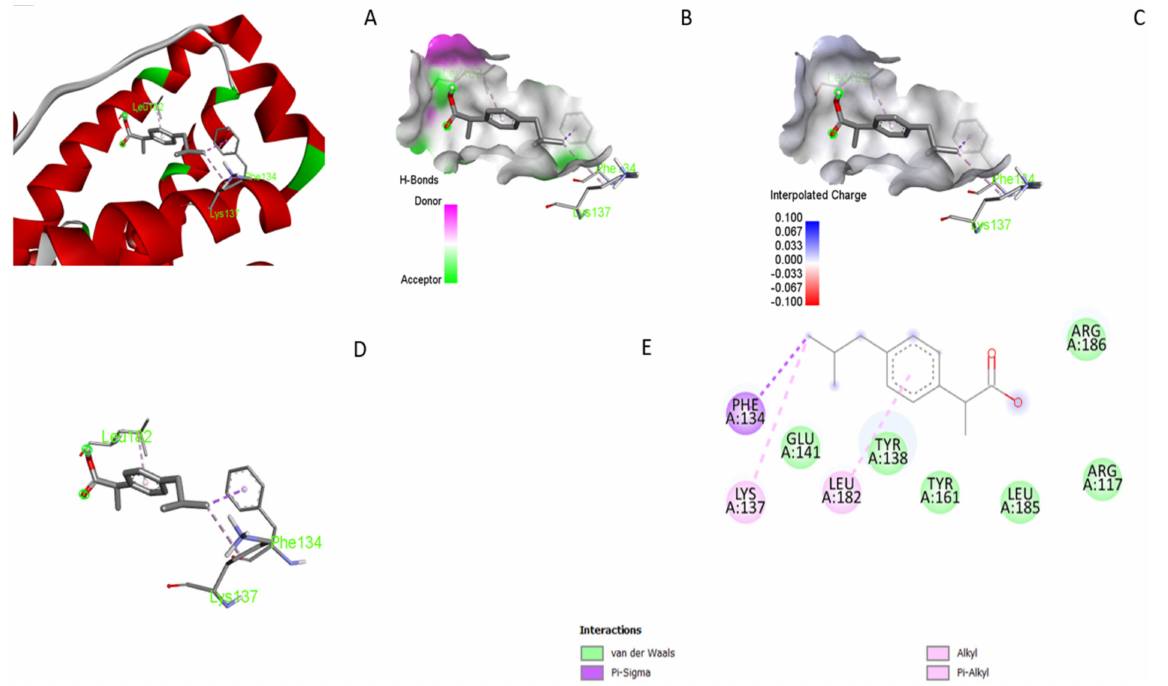
Figure 11. Three-dimensional representation of the interaction of IBU with the receptor ( A ). Although the region where IBU interacts with the receptor is suitable for forming strong hydrogen bonds as both acceptor and donor ( B ), it cannot form a hydrogen bond with the IBU receptor, nor can interact with the electrophilic regions of the receptor ( C ). Instead, IBU only contributes to the docking score with van der Waals interactions, 3D ( D ) and 2D representation ( E